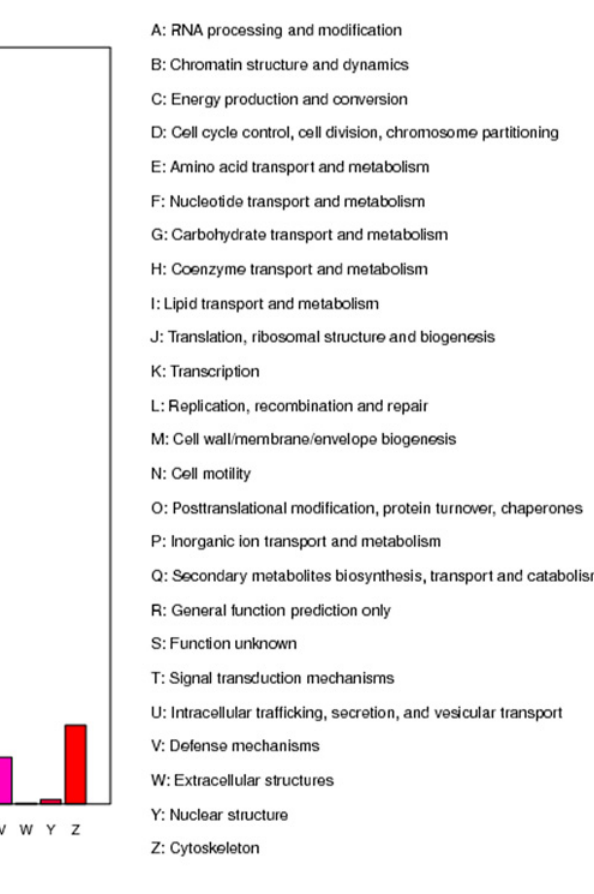
Fig 2. Histogram presentation of clusters of orthologous groups (COG)